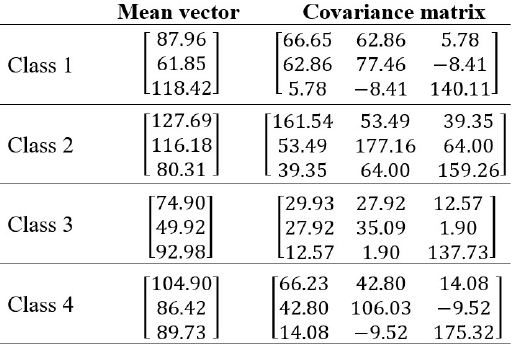
Table 5. Parameters of the trivariate Gaussian distribution of the 4-class, 3-feature case.